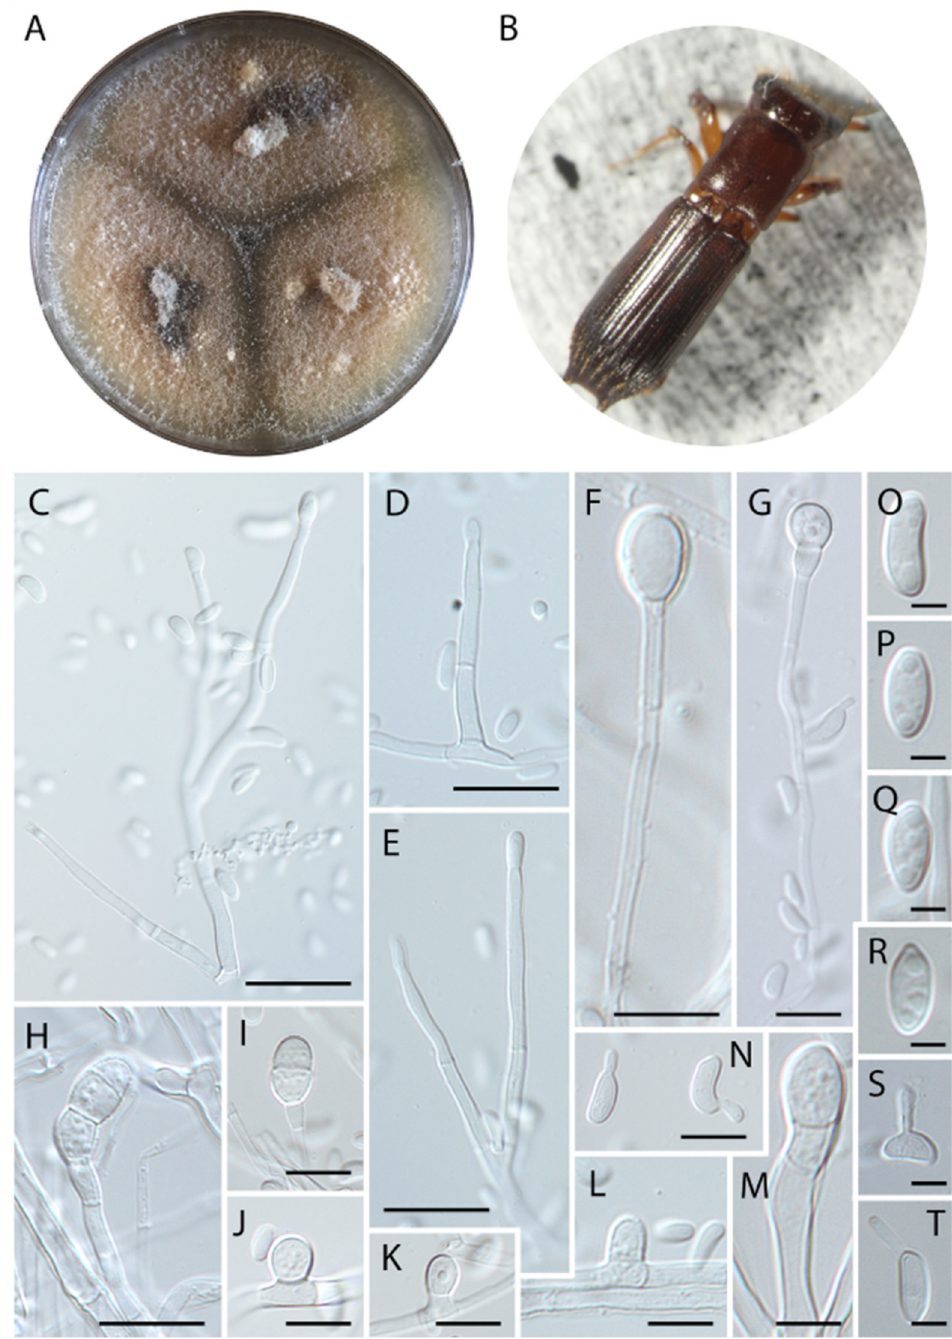
Figure 2. Harringtonia chlamydospora in pure culture on PDA. ( A ) Colony growth after 3 weeks at 25 ◦ C. ( B ) Beetle vector, Euplatypus longius . ( C ) Terminal phialide. ( D ) Lateral phialide. ( E ) Terminal phialide. ( F , G ) Early stages of terminal chlamydospores. ( H , I ) Fully developed chlamydospore. ( J – L ) Micronematous conidiogenous cells formed laterally on the vegetative hypae. ( M ) Chlamy- dospore. ( N ) Germinating conidia. ( O – R ) Conidia. ( S , T ) Conidia exhibiting germ tube. Scale bars: ( C – E ) = 10 µ m, ( F , G ) = 20 µ m, ( H ) = 20 µ m, ( I ) = 10 µ m, ( J – L ) = 5 µ m, ( M ) = 10 µ m, ( N ) = 5 µ m, ( O – T ) = 2 µ